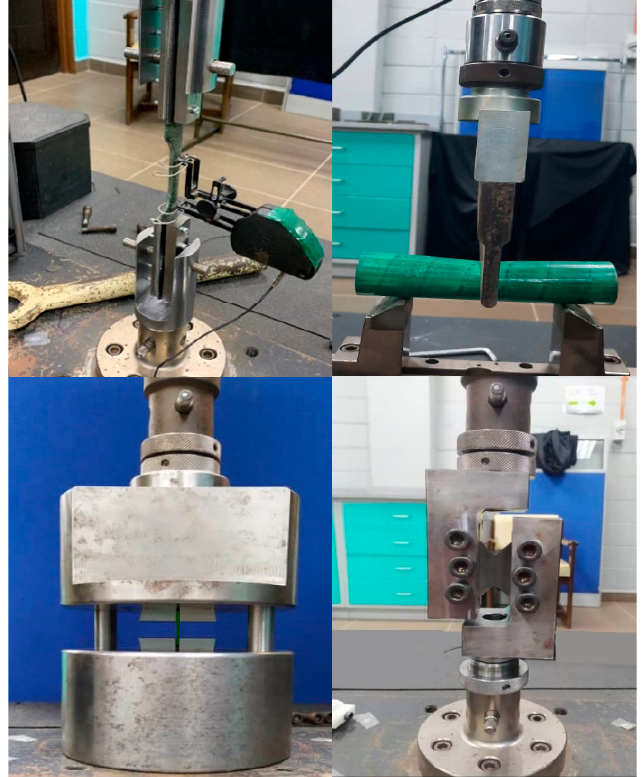
Figure 3. Setup of the experiment for material characterization. Table 2. The material properties of hybrid carbon/glass fibre/epoxy unidirectional composite.